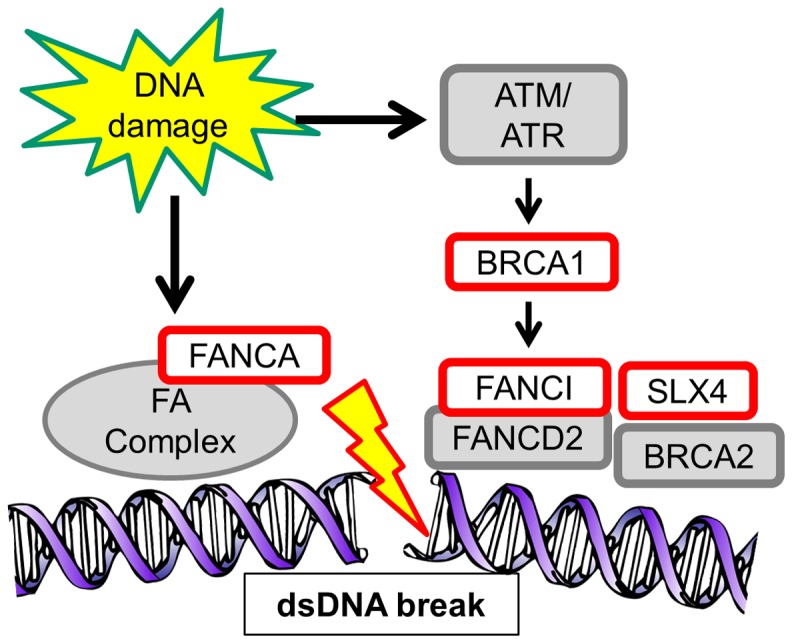
Double-stranded DNA repair pathway.Genes identified in the analyses are shown in red. When DNA is damaged, damage sensors promote recruitment and assembly of a repair complex comprised of Fanconi Anemia (FA) genes, BRCA1 and other proteins to the site of damage.